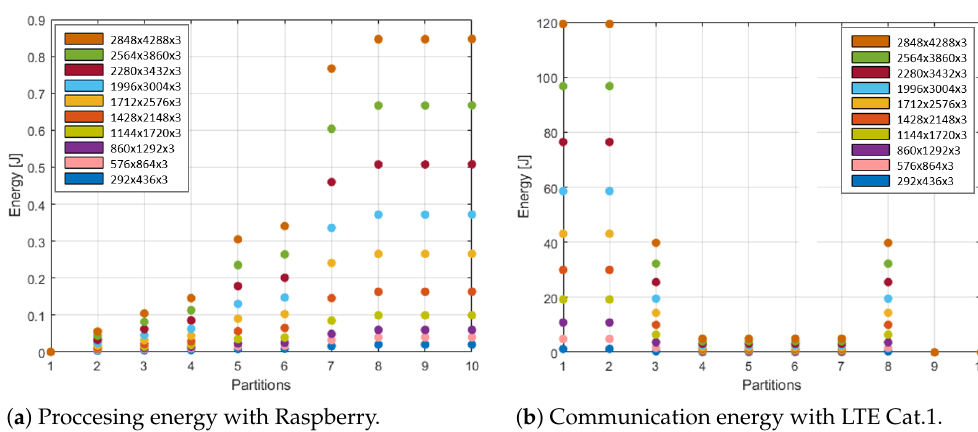
Figure 8. Energy per partition along the system as a function of the image size for an image with 18 objects. What was mentioned in the caption of Figure 7 also applies to